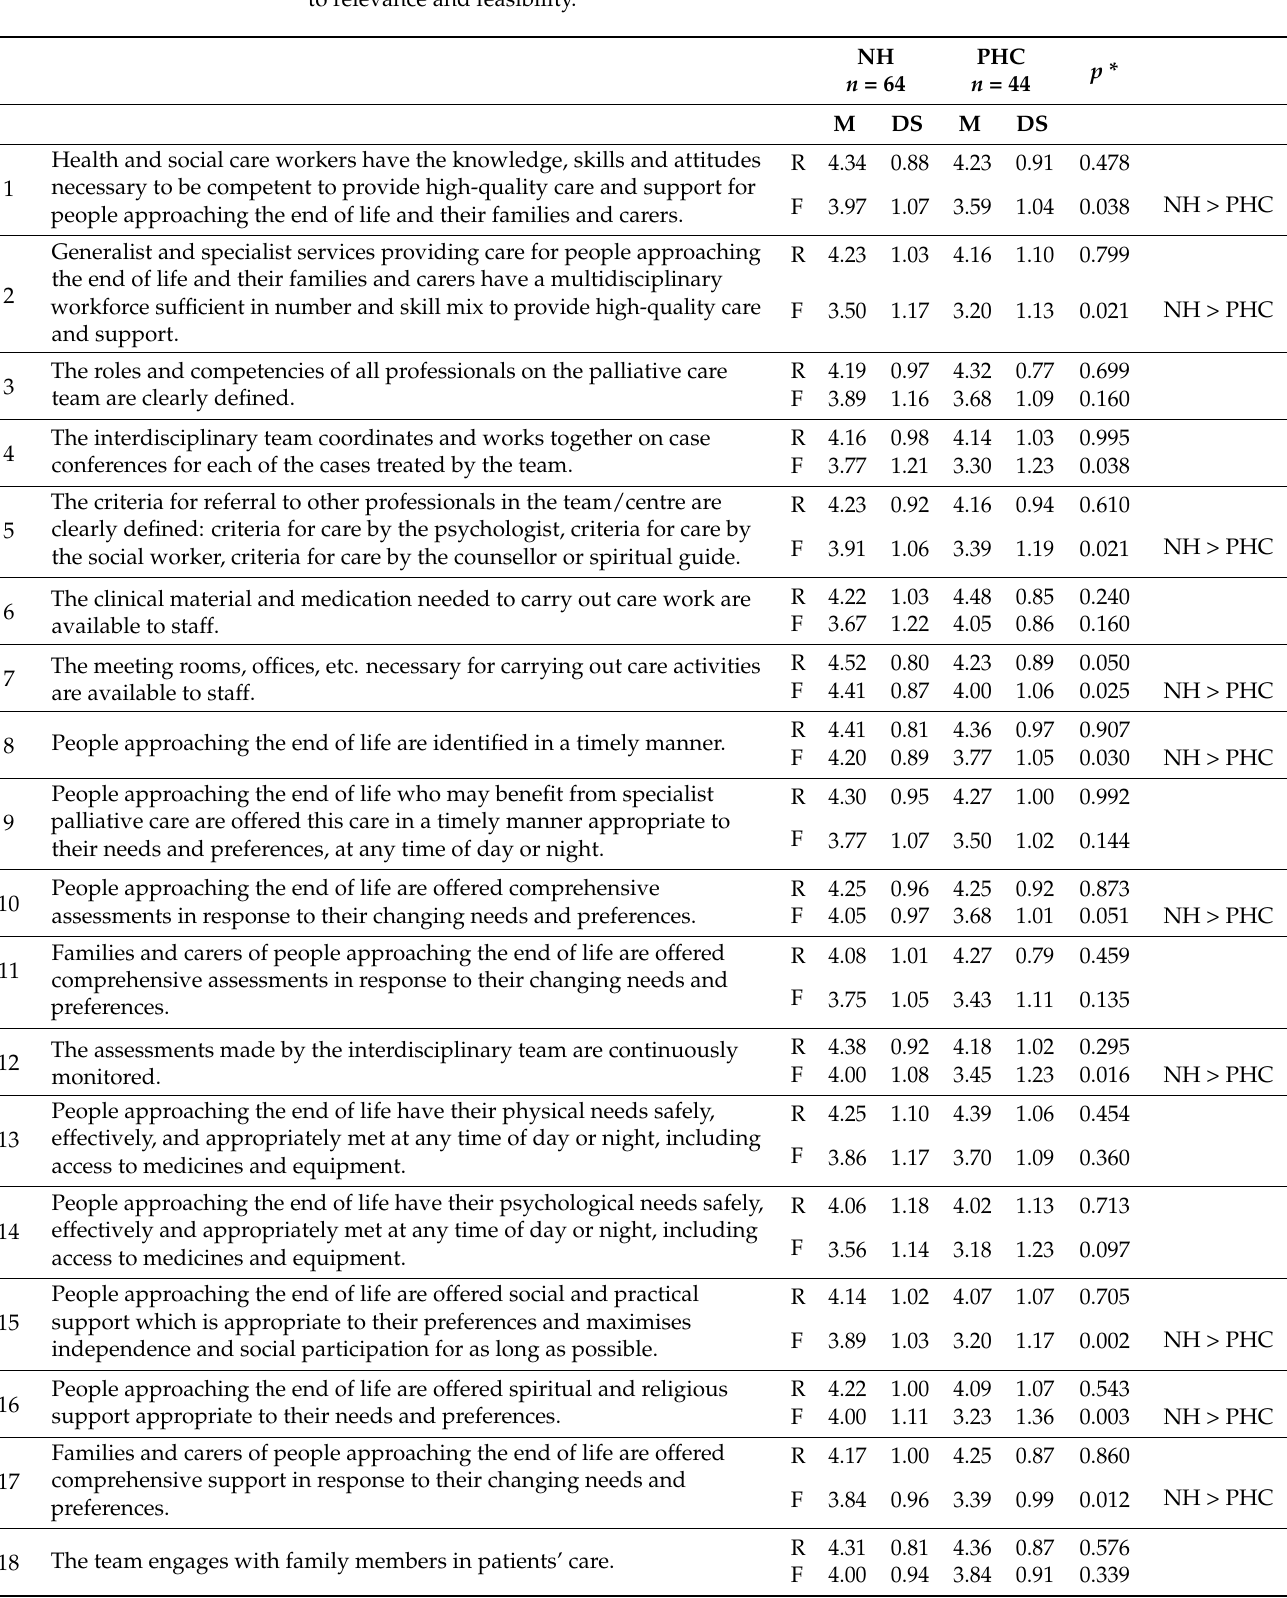
Table 3. Scores given by nursing home (NH) and primary health care (PHC) professionals, according to relevance and